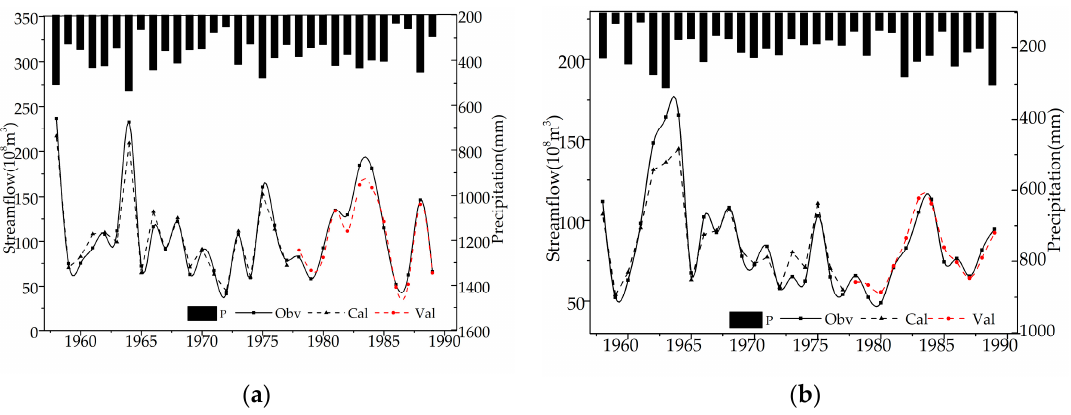
Figure 7. Observed and simulated streamflow in Long-Hua region during the calibration and validation period in the flood season model ( a ) and nonflood season model ( b ).